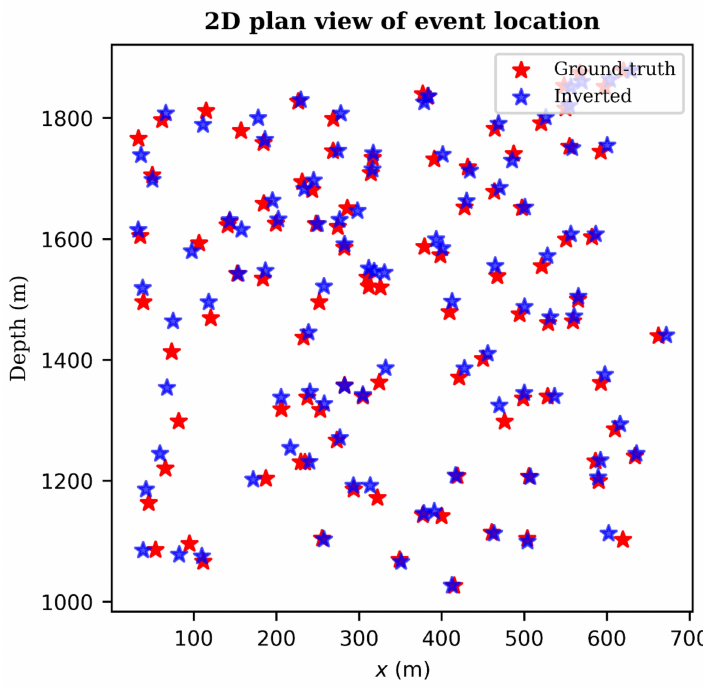
Figure 8. 2D plan view projection of the inverted DAS microseismic depth locations (blue stars) versus ground-truth locations (red stars). Only 100 events from one velocity model are displayed.